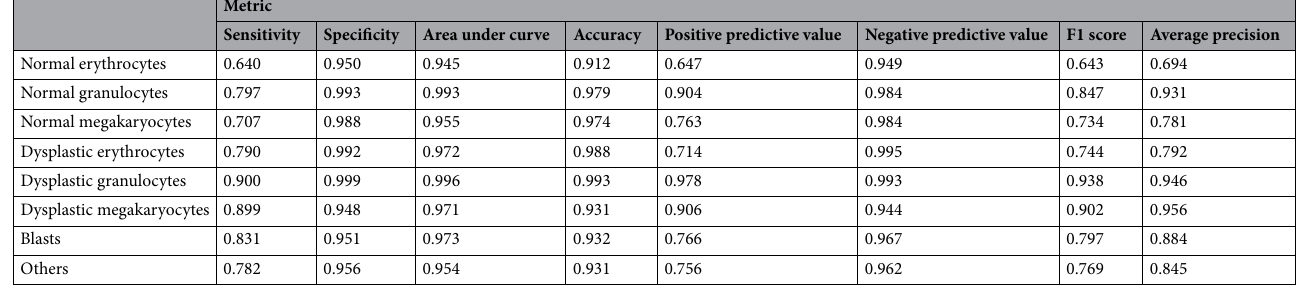
Table 3. Summary of performance including area under the receiver operating characteristic curve for each finding in database.